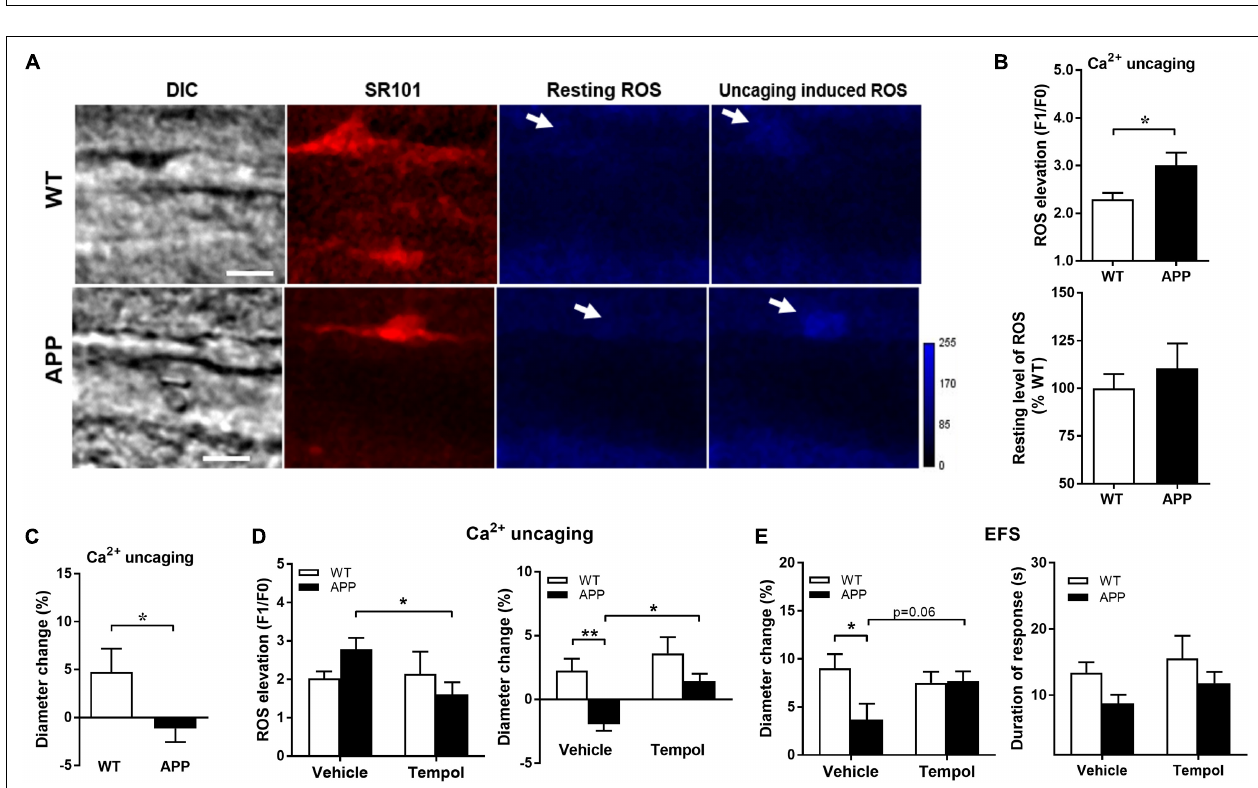
FIGURE 5 | Increased amplitude of spontaneous Ca 2 + oscillations in astrocytic endfeet of APP mice. (A) Averaged (left panel) and maximal amplitude (right panel) and (B) frequency of spontaneous Ca 2 + oscillations in astrocytic endfeet of hippocampal slices from WT and APP mice (* p < 0.05; two-tailed unpaired t -test; n = 4–13). F1/F0: fractional fluorescence.